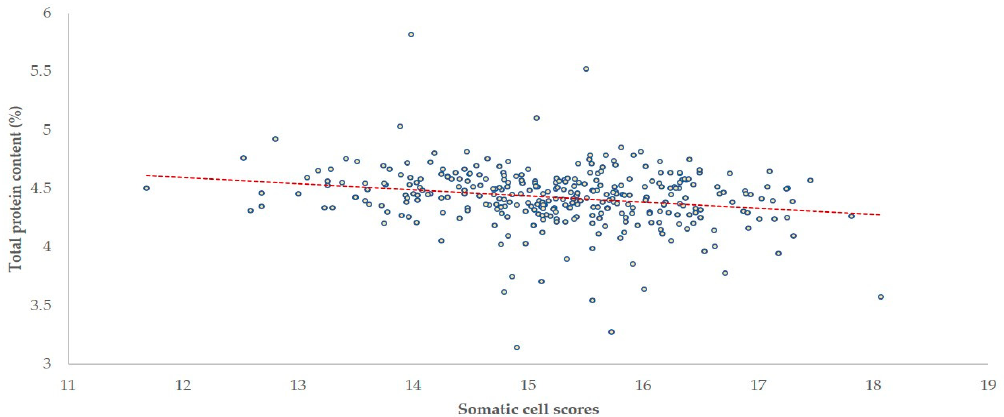
Figure 8. Somatic cell scores [log 2 (SCC/100) + 3] and total protein content in the bulk-tank milk of 325 sheep flocks in Greece (dashed line: tendency line).